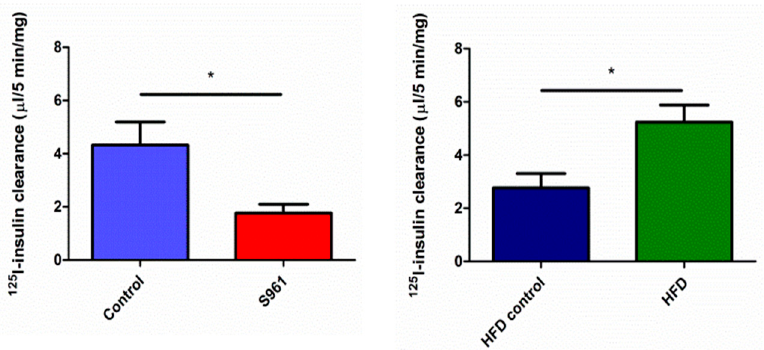
Figure 2. Clearance of radiolabeled insulin by skeletal muscle in rats studied +/- S961 under proto- col 1 (left panel) or after feeding a chow diet (blue) or a high-fat diet (green) for four weeks (right panel). ** indicates significance ( p <0.01).